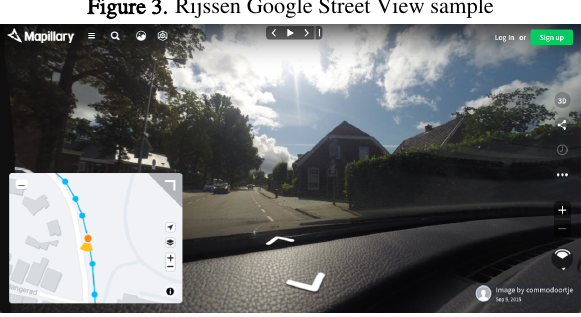
Figure 4. Rijssen Mapillary